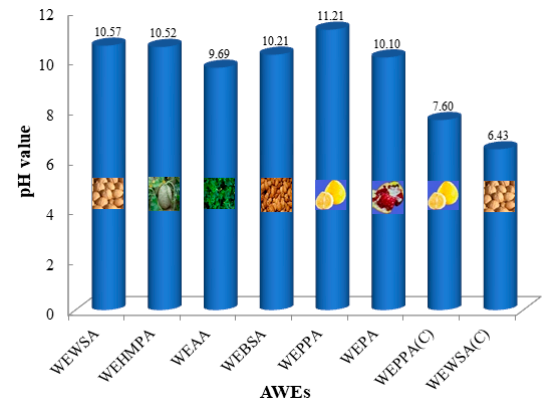
Figure 2. pH values of AWEs.